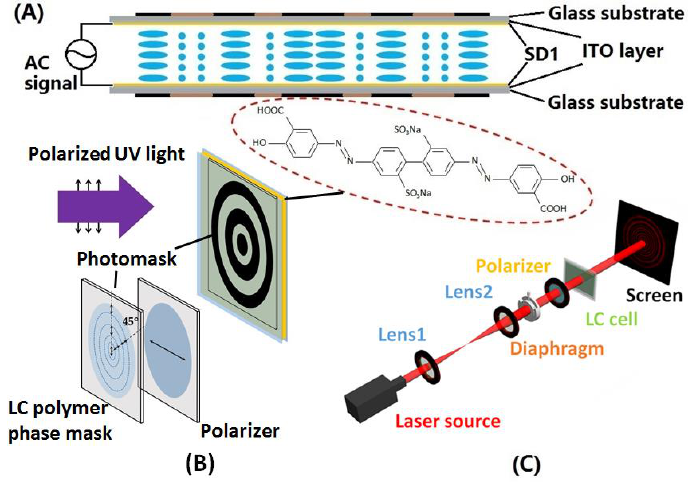
Figure 1. The fabrication of the proposed liquid crystal (LC) circular Dammann grating (CDG) and the experimental setup for measurement. ( A ) Schematic side view of the configuration of the LC CDG driven by an alternating current (AC) signal. ( B ) The photoalignment process with the molecular structure of SD1 shown in the red dotted oval. ( C ) The experimental setup for measuring the optical properties of the LC CDG.